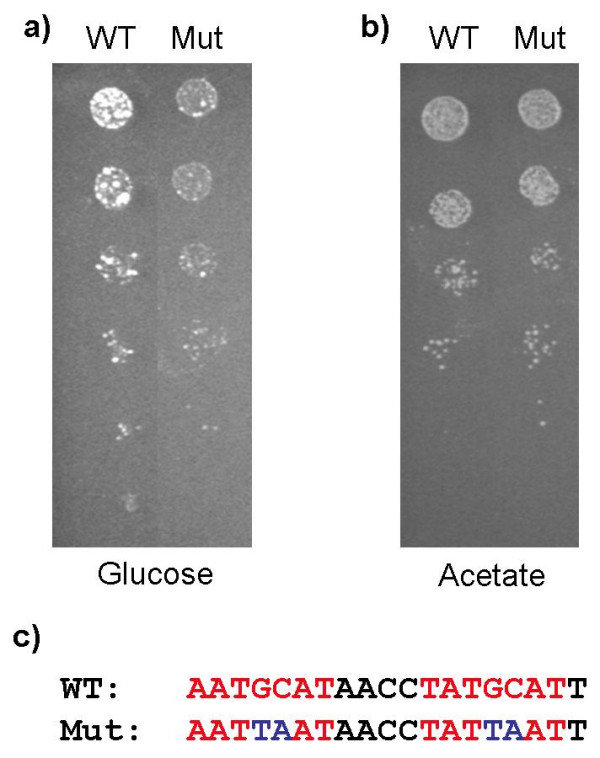
Activation of the reporter gene through the putative motif. (a) Growth on glucose containing 2 mM 3AT with the wild type motif (left) and the mutant motif (right) upstream of the reporter. (b) Growth on acetate containing 0.5 mM 3AT with the wild type motif (left) and the mutant motif (right) upstream of the reporter. (c) Sequences used for the reporter assay. Motifs are shown in red and mutations are shown in blue.